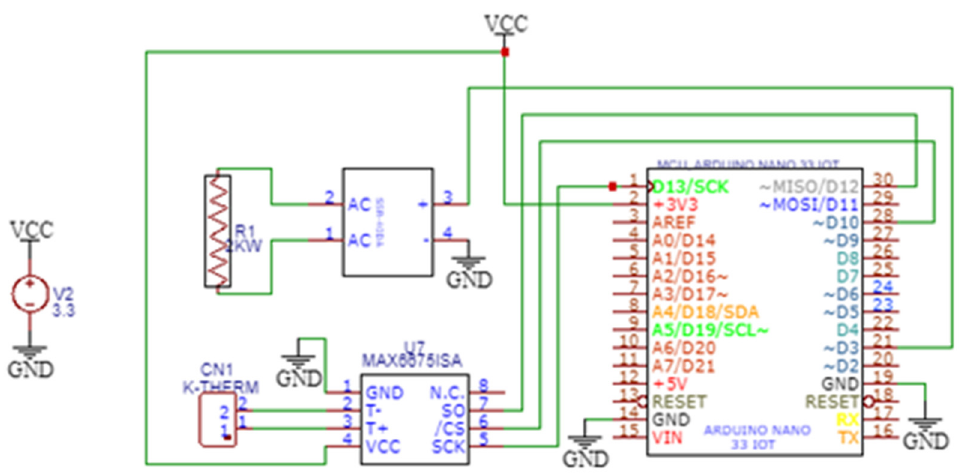
Figure 4. IoT-based control system schematic